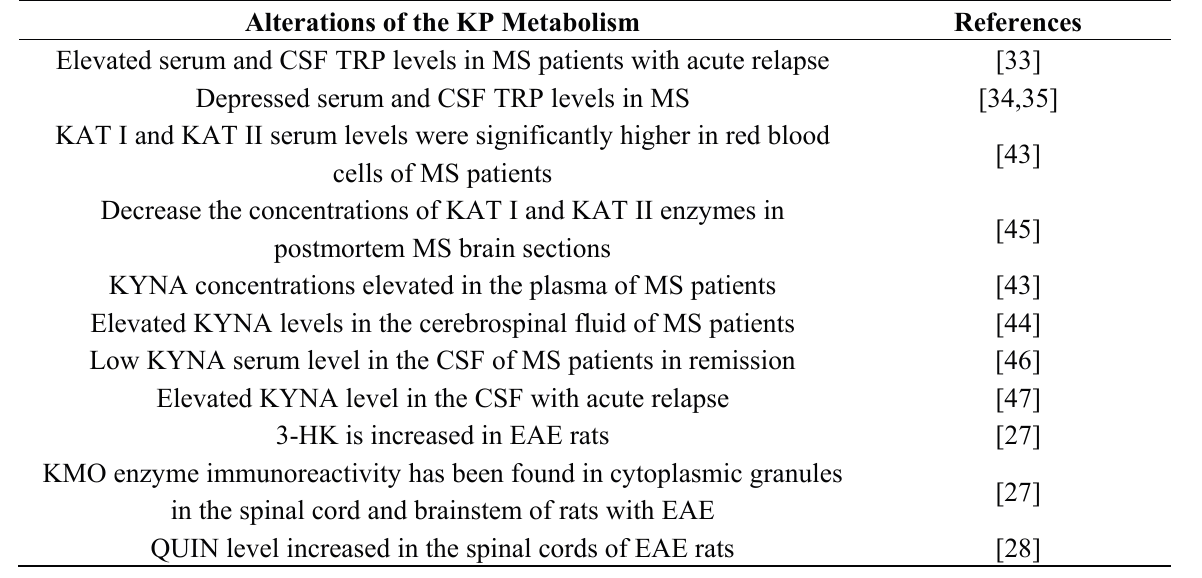
Table 1. The role of kynurenine pathway in MS and its experimental animal model-findings in connection with the